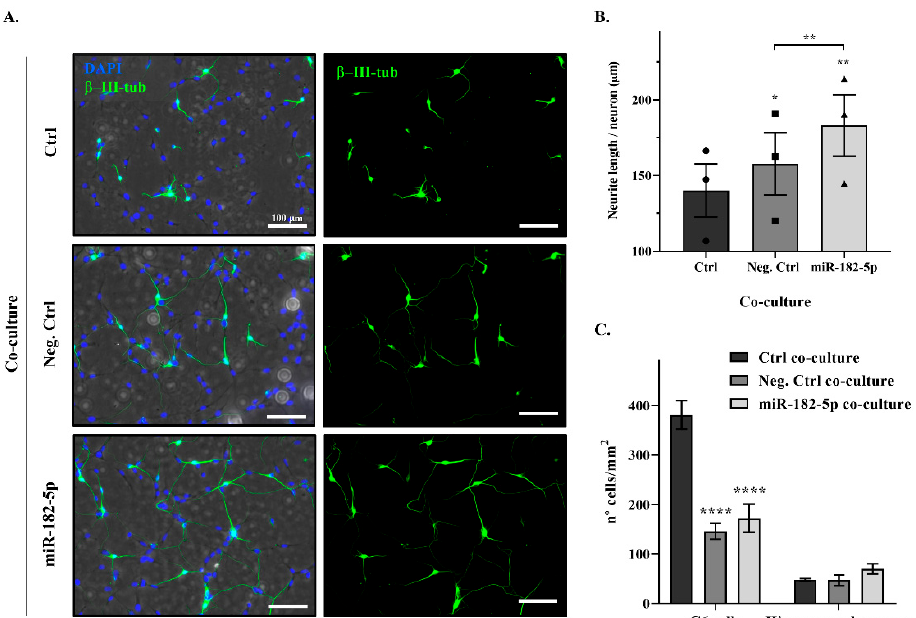
Figure 4. Nogo-A downregulation by miR-182-5p mimic promotes neurite outgrowth of primary hippocampal neurons. ( A ) Representative phase contrast and epifluorescence images of different co-cultures of C6 cells (non-transfected control cells; negative control mimic transfected cells; miR- 182-5p mimic-transfected cells; imaged in phase contrast) and rat hippocampal neurons, labeled with the specific neuronal marker β -III tubulin (green) and DAPI (nuclei staining, blue). Bar scale = 100 µm. ( B ) Bar graph shows the mean ± SEM of three independent experiments of neurite length per neuron (µm) of mimic-transfected C6 cell co-cultures in comparison with the non-transfected C6 cell co-culture values (two-tailed paired t-test; negative control co-culture, T 2 = 5.041, p = 0.0372; miR-182-5p co-culture, T 2 = 15.46, p = 0.0042) and the comparison between both mimics-transfected C6 cell co-cultures (two-tailed paired t-test; T 2 = 17.65, p = 0.0032). * indicates a p -value < 0.05, and ** indicates a p -value < 0.01. ( C ) Bar graph shows the mean ± SEM of three independent experiments of the evaluation of the number of C6 cells and hippocampal neurons per mm 2 (density) in the different co-cultures. Mimic transfection showed statistical reduction in the number of C6 cells (Tukey’s multiple comparison post hoc test, p < 0.0001). **** indicates a p -value < 0.0001.